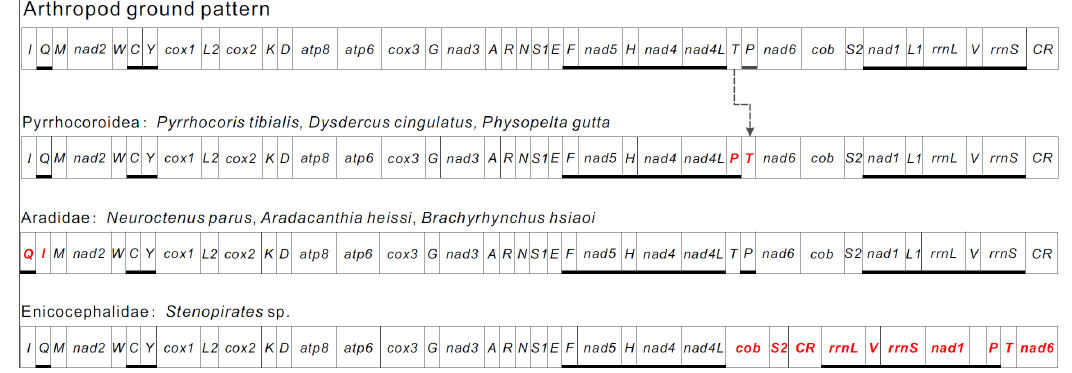
Figure 2 . Mitochondrial gene rearrangement among Heteroptera. Abbreviations of gene names follow Figure 1. Genes are transcribed from left to right except those underlined, which have the opposite transcriptional orientation. Rearrangements of mitochondrial genes were highlighted by a red color.